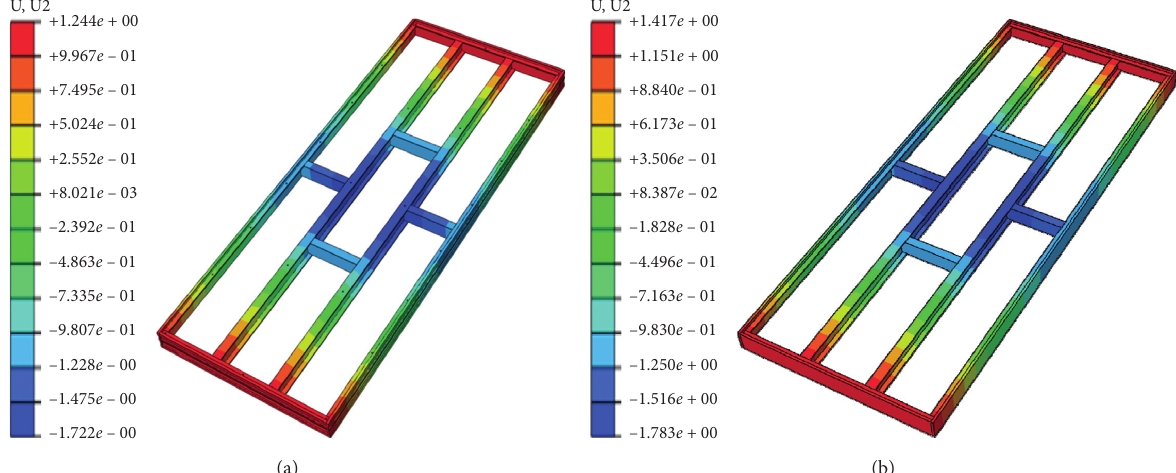
Figure 21: Deflections of the frame (unit: mm). (a) Refined model. (b) General